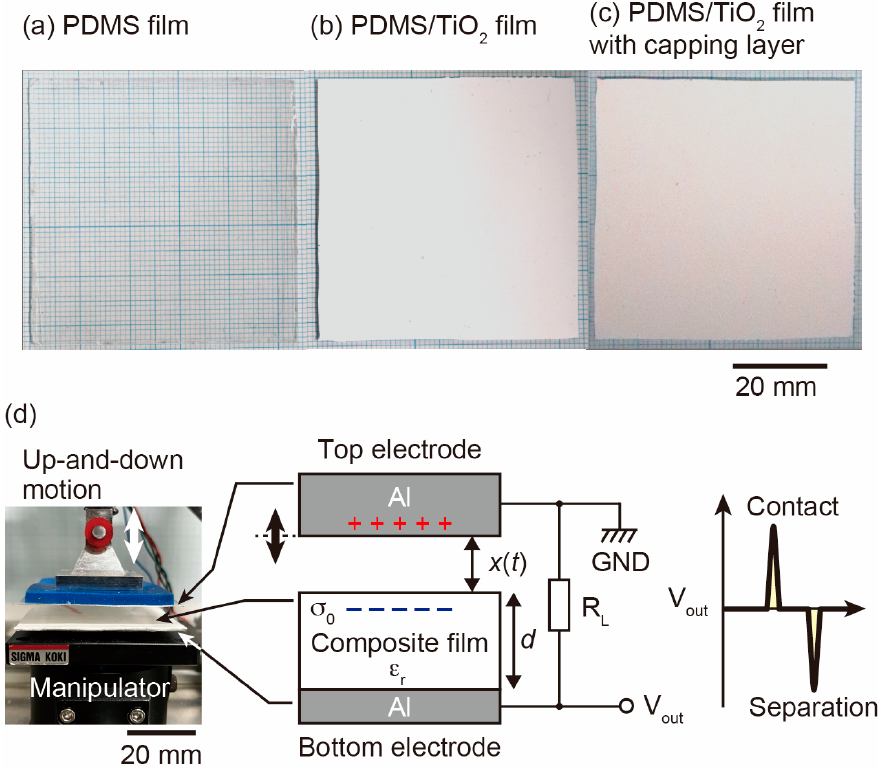
Figure 1. Photographs of ( a ) PDMS film, ( b ) PDMS/TiO 2 film, and ( c ) PDMS/TiO 2 film with a PDMS capping layer. ( d ) A schematic of the apparatus used to characterize the power generation and the typical profile of the output voltage.